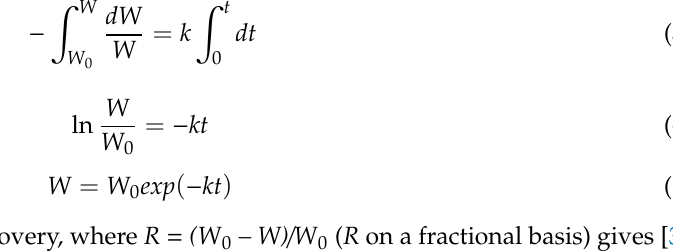
Figure 9. Final copper recoveries without NaHS and with NaHS dosages of 50 g / t, 100 g / t, and 200 g / t